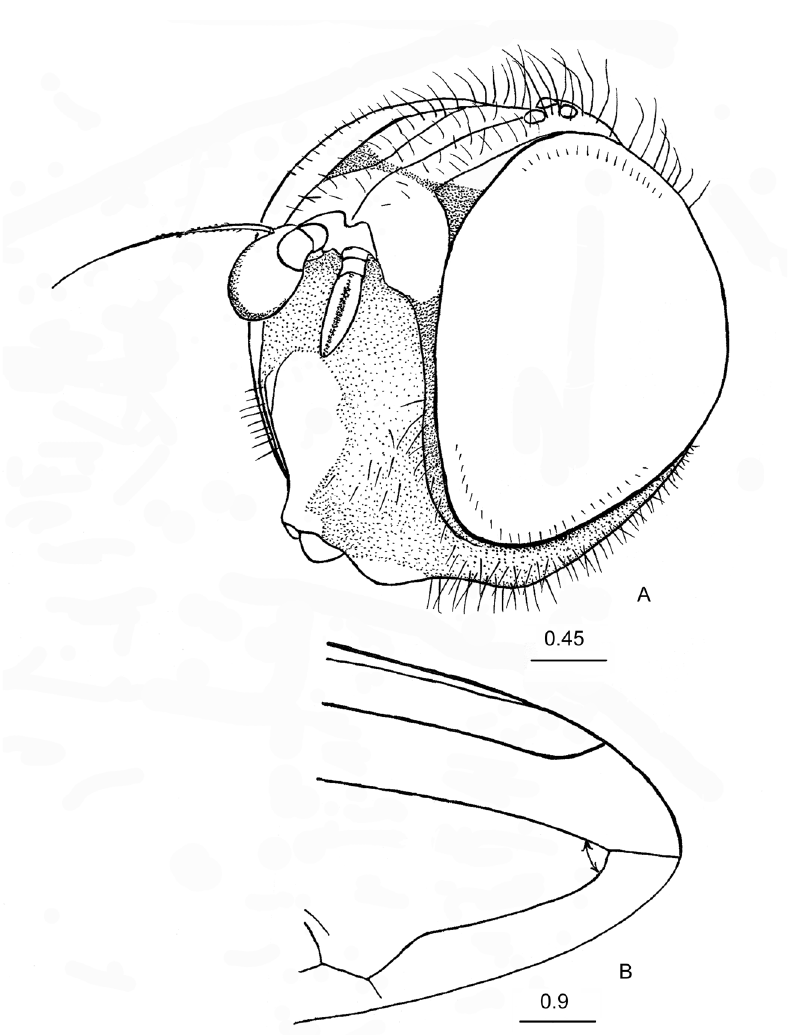
Fig. 65. Cheilosia versa sp. nov., holotype, ♀ (CNC). A . Head, lateral view. B . Tip of wing. Scale bars indicated in